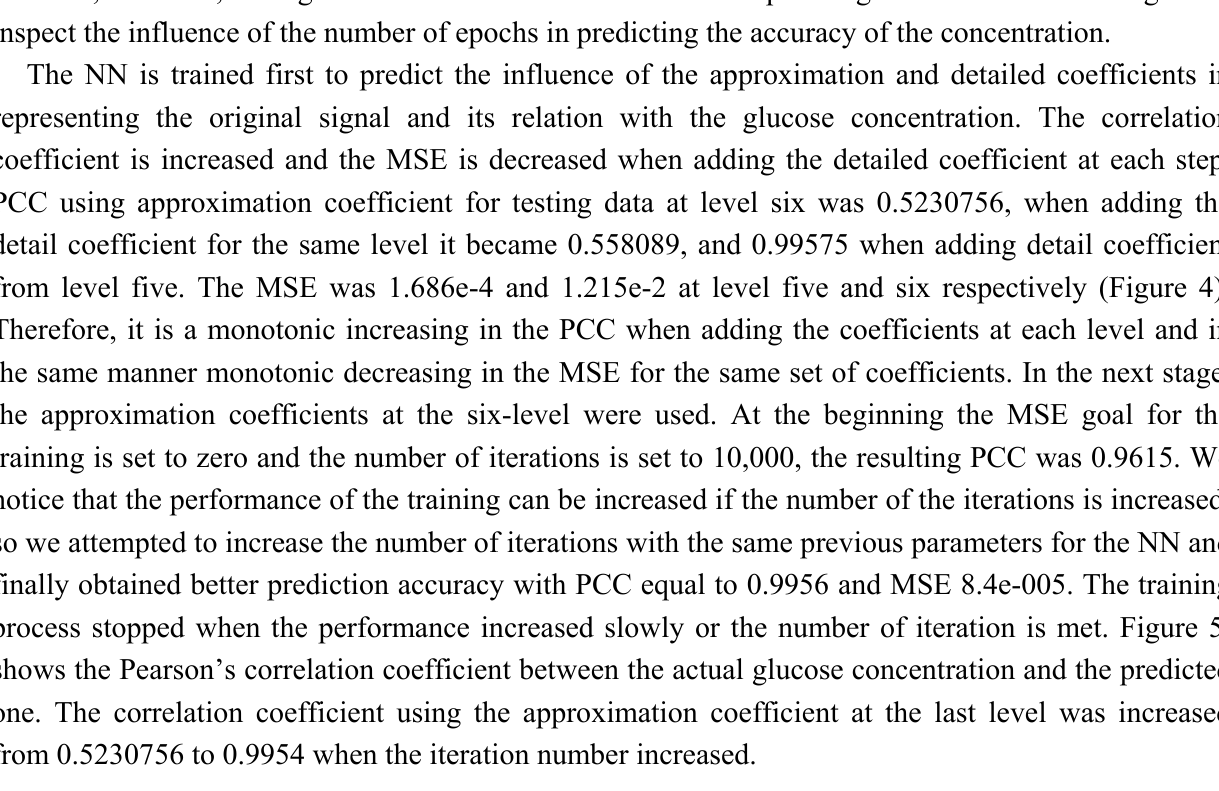
Figure 4. Mean Square Error (MSE) for different set of